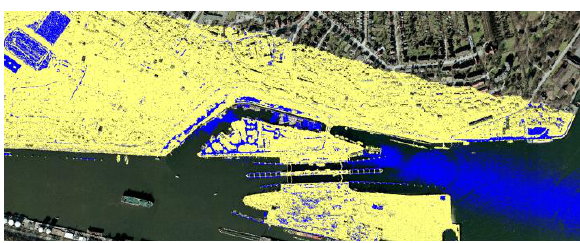
Figure 7: Water (blue) an land (yellow) points after classification by height variation, intensity variation